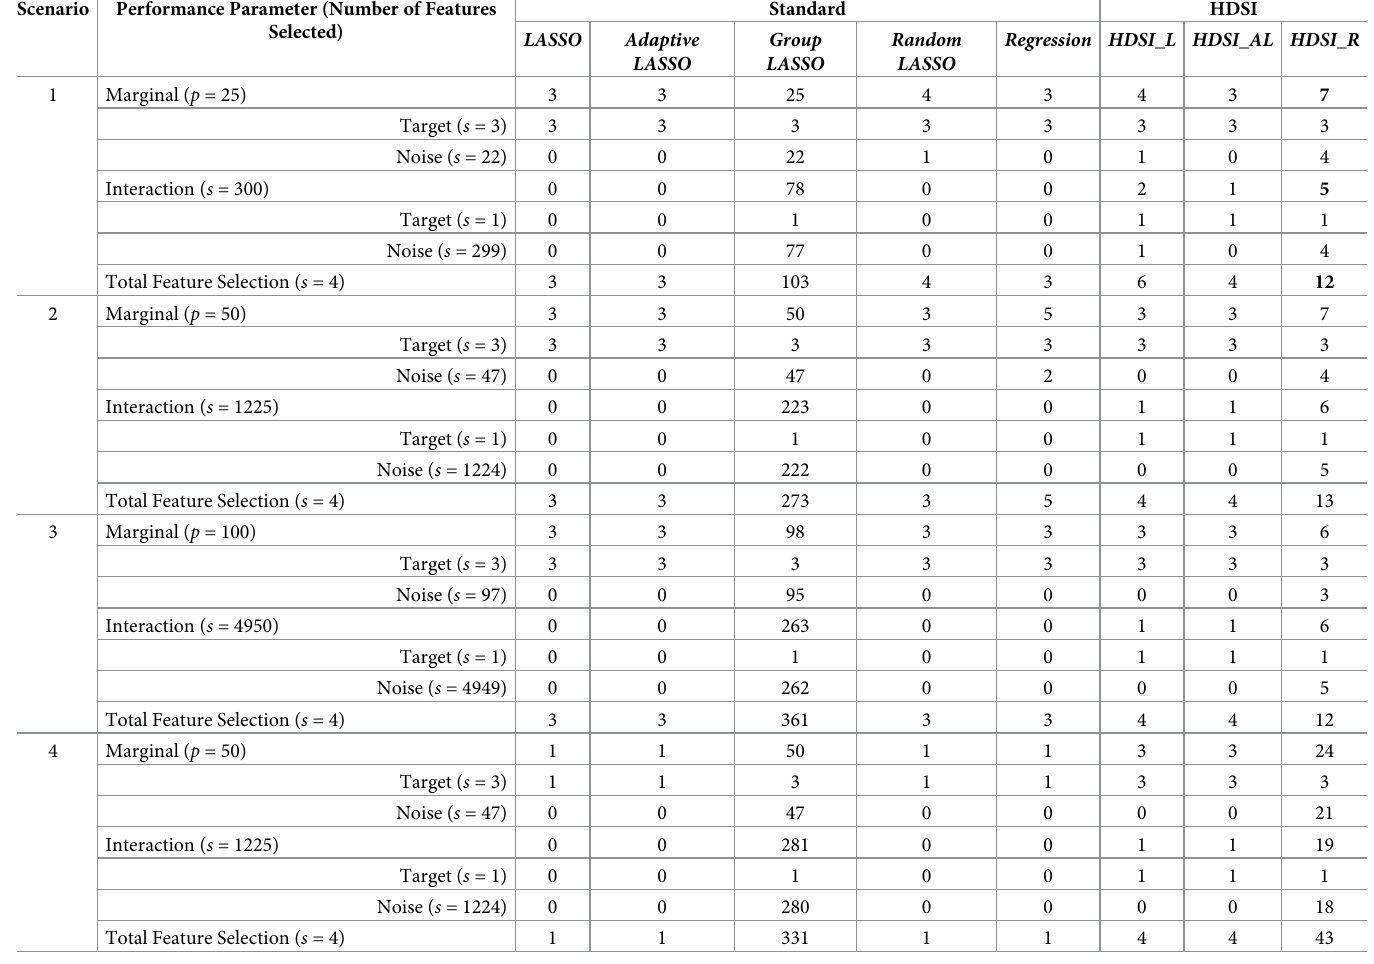
Table 4. Feature selection performance of different approaches in simulated